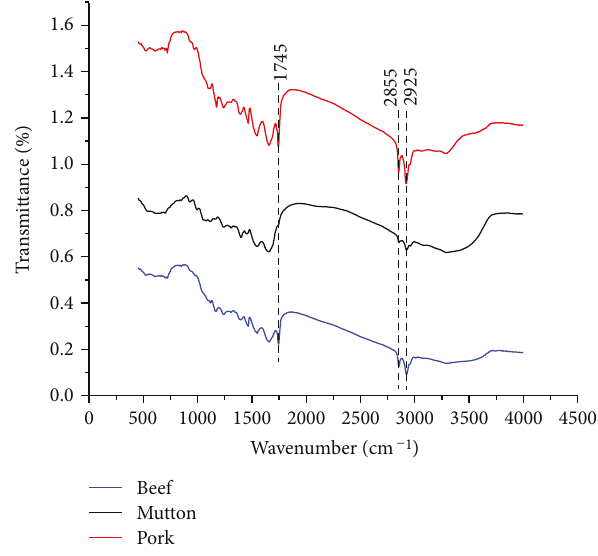
Figure 2: Average values of the absorbed spectrum of pork (blue), beef (black), and mutton